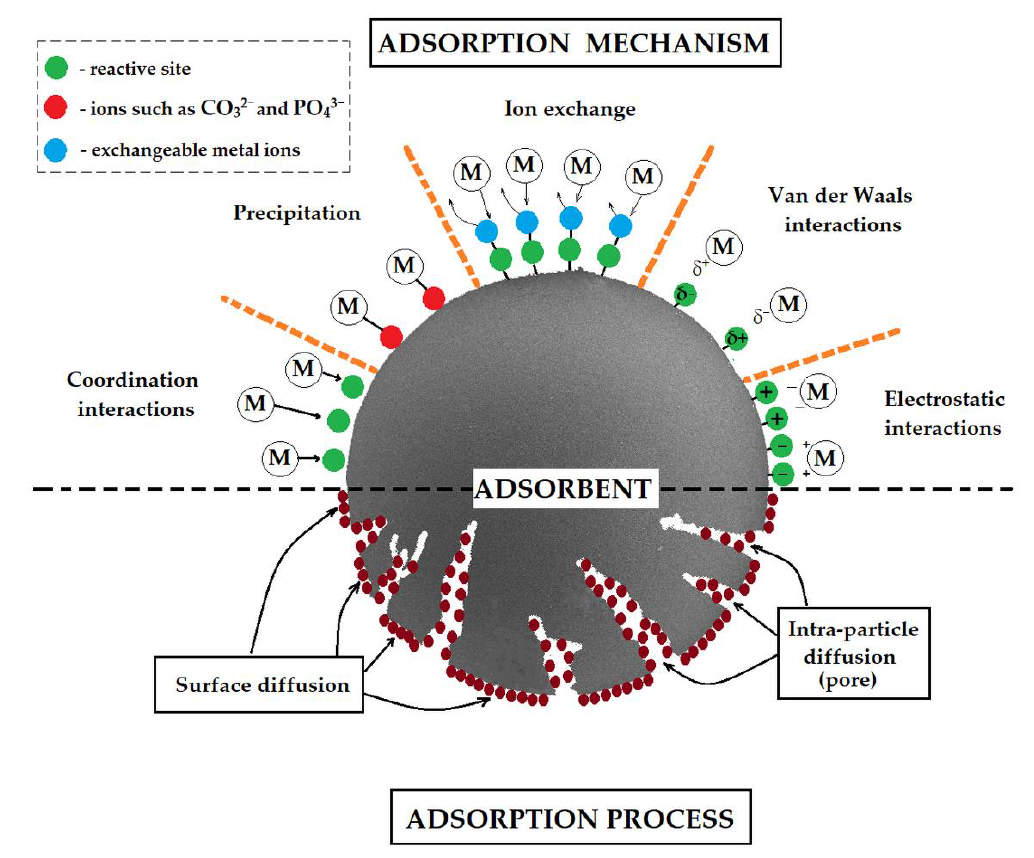
Figure 1. Schematic representation of possible metal adsorption mechanisms by polymer sorbents.